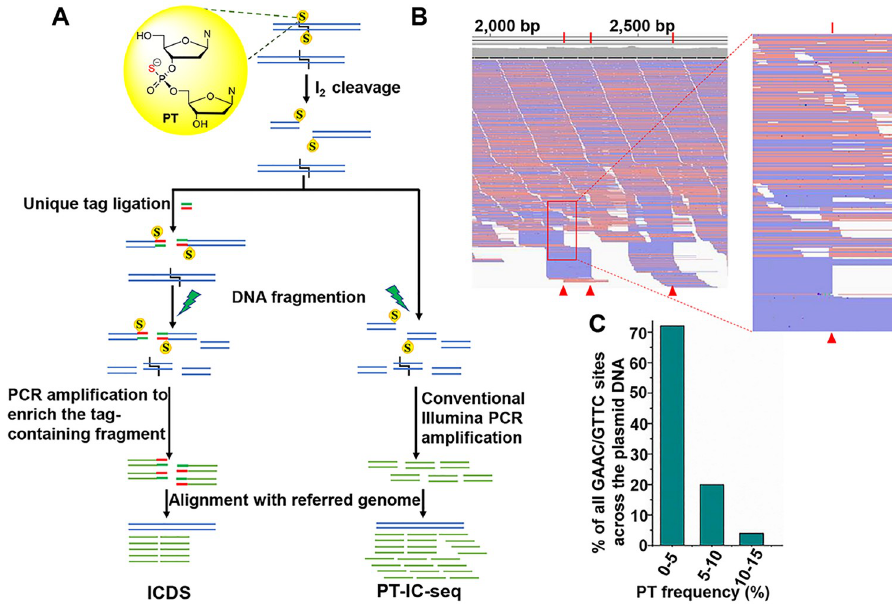
Fig 2. PT-IC-seq, a new method for quantitatively PT mapping. (A) Flowchart of ICDS and PT-IC-seq. The treatment of bistranded PT modified DNA with I 2 will produce a double-strand break. In the ICDS method, after treatment with I 2 , the resulted double-strand break is then processed and ligated to a unique double-stranded oligodeoxynucleotide tag, followed sonicated to an optimal range (150–350 bp) in length. After Illumina adaptors addition, the DNA is subjected to PCR amplification to enrich the I 2 cleaved fragments. And finally, subjected to Illumina sequencing. While, in the PT-IC-seq method, after treatment with I 2 , the resulted double-strand broke into long DNA fragments were directly fragmented. Following addition of Illumina adaptors, the DNA is subsequently subjected to PCR amplification and sequencing. (B) The snapshot of genome browser (IGV) representing a partially PT modified sites in pBlueScript SK(+) plasmid extract from S . enterica serovar Cerro 87. The top track shows counts of 5’ ends in the selected region. Blue segments represent reads mapped to the minus strand and red segments represent reads mapped to the plus strand. The red triangle marks G ps AAC/G ps TTC site. (C) Statistics analysis of the PT modification frequency in pBlueScript SK(+) plasmid extract from S . enterica serovar Cerro 87. All of the PT modified sites in the pBlueScript SK(+) plasmid extract from S . enterica serovar Cerro 87 are partially-PT modified, and more than 70% of the PT modified sites with the PT ratio lower than